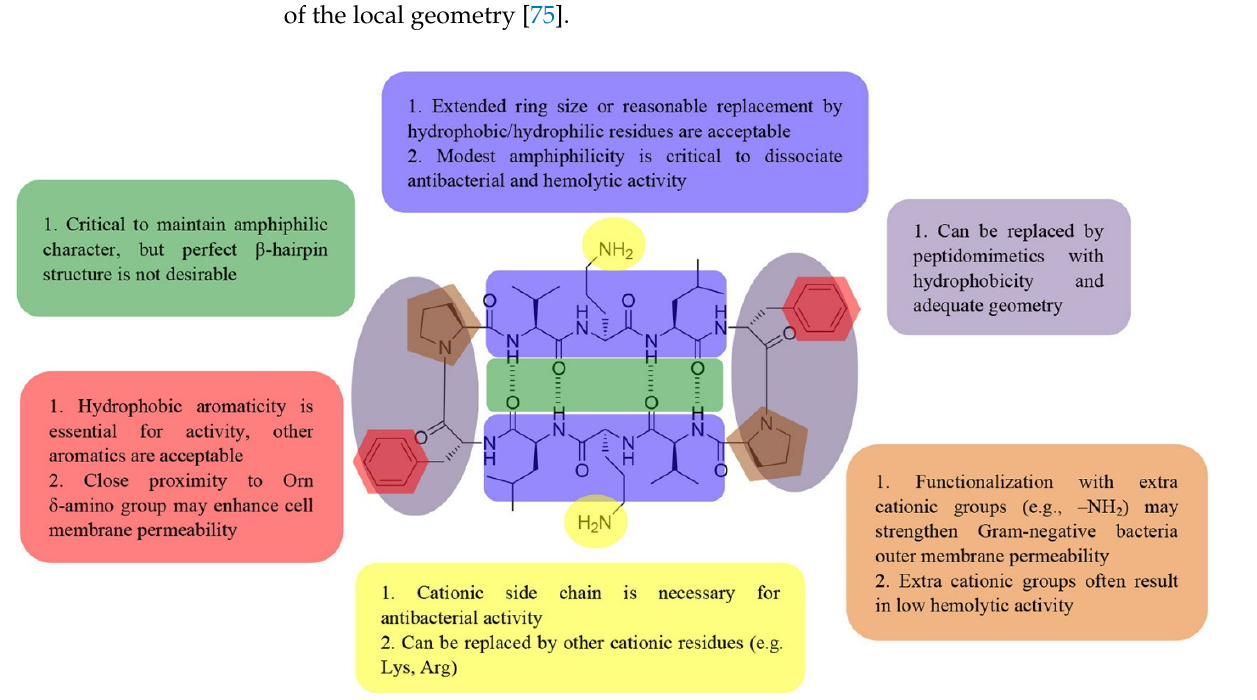
Figure 5. Gramicidin S structure-activity relationship. Reprinted with permission from Ref. [75]. Copyright 2019 American Chemical Society.